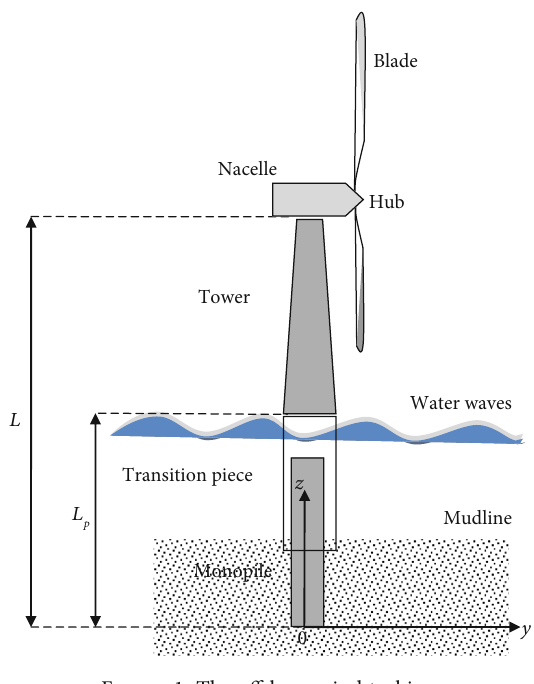
Figure 1: The o ff shore wind turbine.